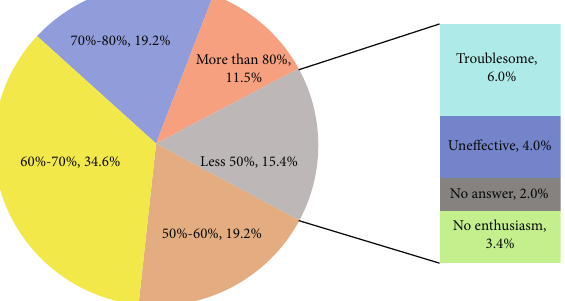
Figure 7: Problems of intelligent question answering self-test